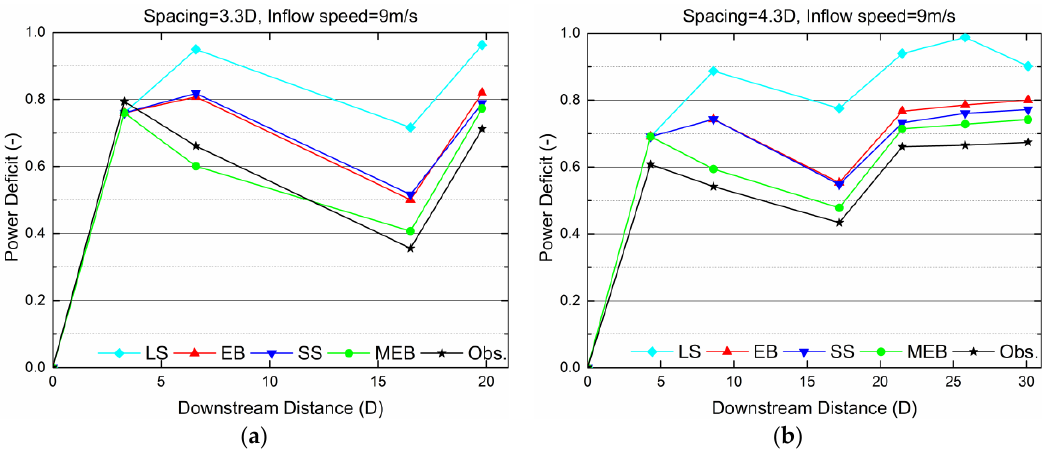
Figure 5. Lillgrund power deficit in a row with ( a ) 3.3D spacing with two missing turbines and ( b ) 4.3D spacing with one missing turbine.